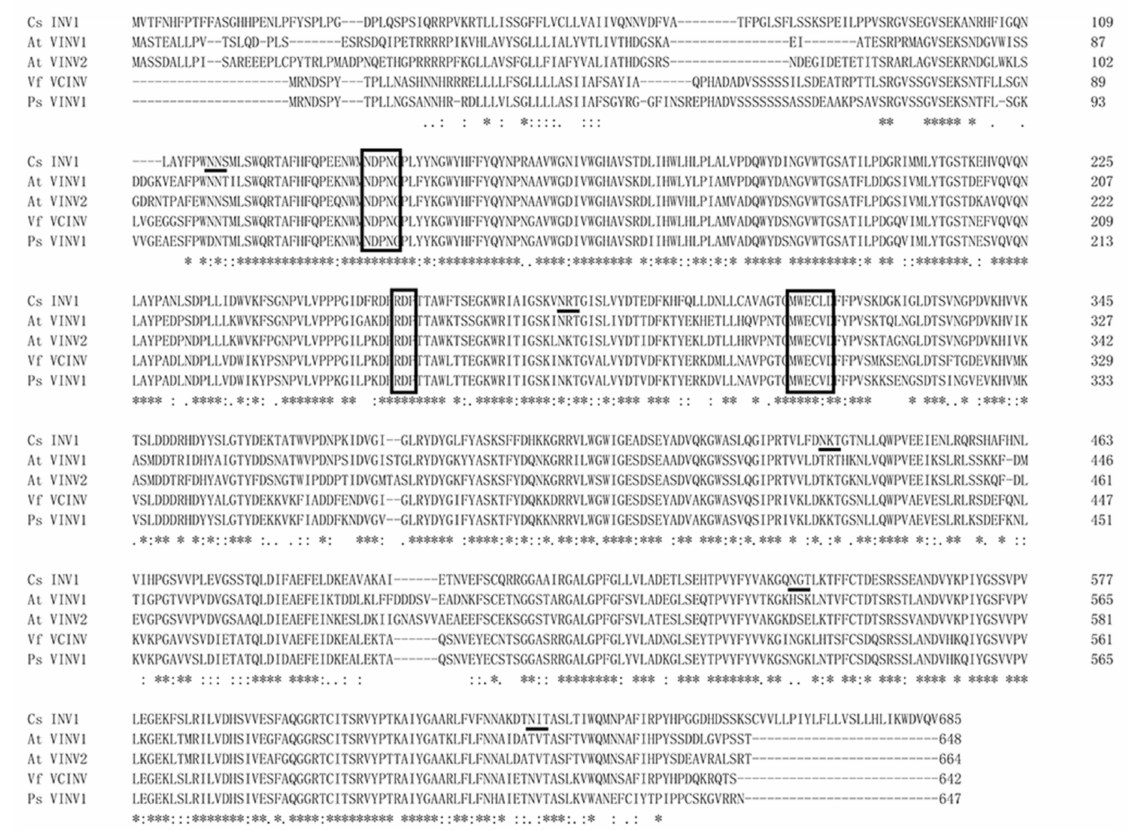
Figure 7. Alignment of the CsVI1 amino acid sequence with vacuolar invertases from other dicot species. The amino acid sequences were aligned using ClustalW Omega (https://www.ebi.ac.uk/Tools/msa/clustalo/, accessed on 11 March 2019). Putative β -fructosidase motifs (NDPNG/A), cysteine-containing catalytic sites (MWECP/V), and conserved Asp residues (D) are shown in boxes. Putative glycosylation sites are underlined. Asterisks indicate identical residues, colons indicate conserved substitutions, and periods indicate semi-conserved substitutions.